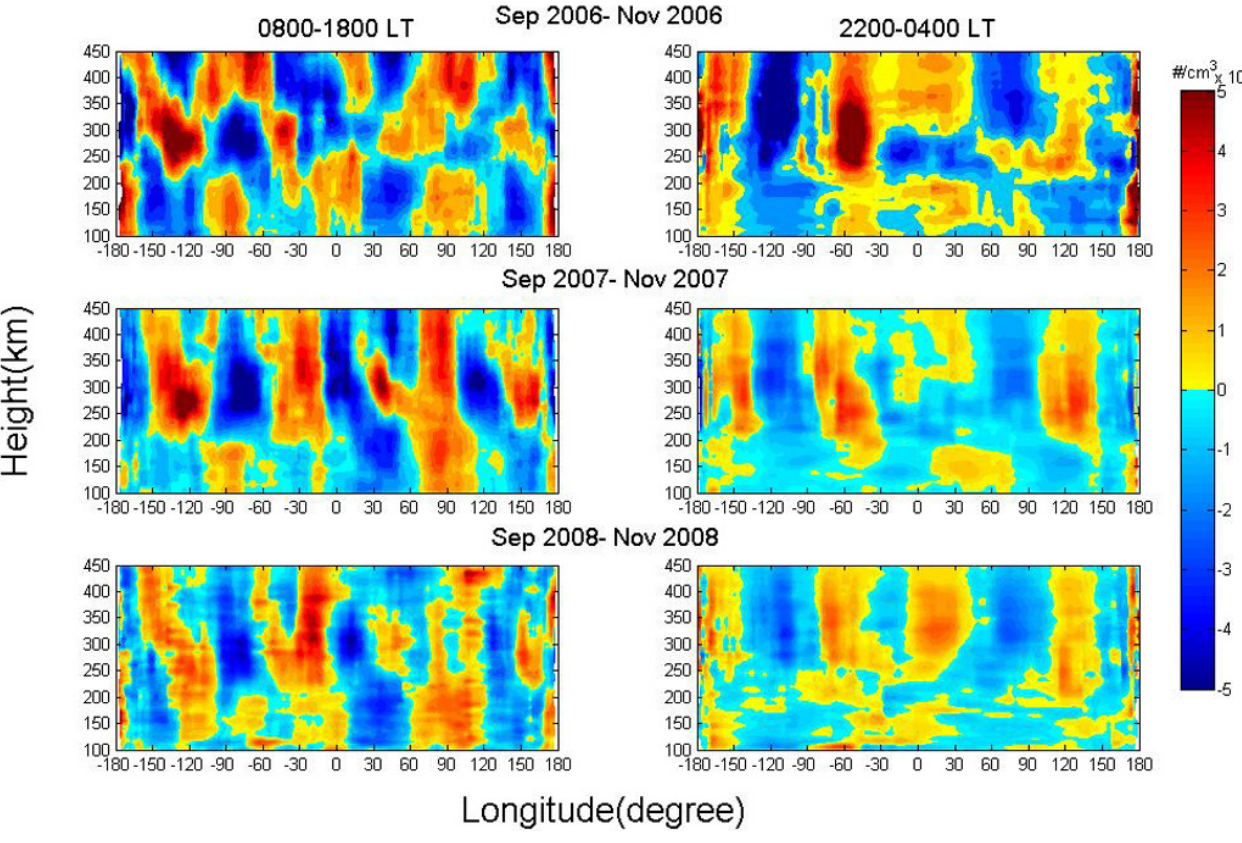
Fig. 2. Longitude versus altitude electron densities (residuals) during September equinox 2006 (upper panels), 2007 (middle panels), and 2008 (bottom panels) for both daytime (08:00–18:00LT) and nighttime (22:00–04:00LT).